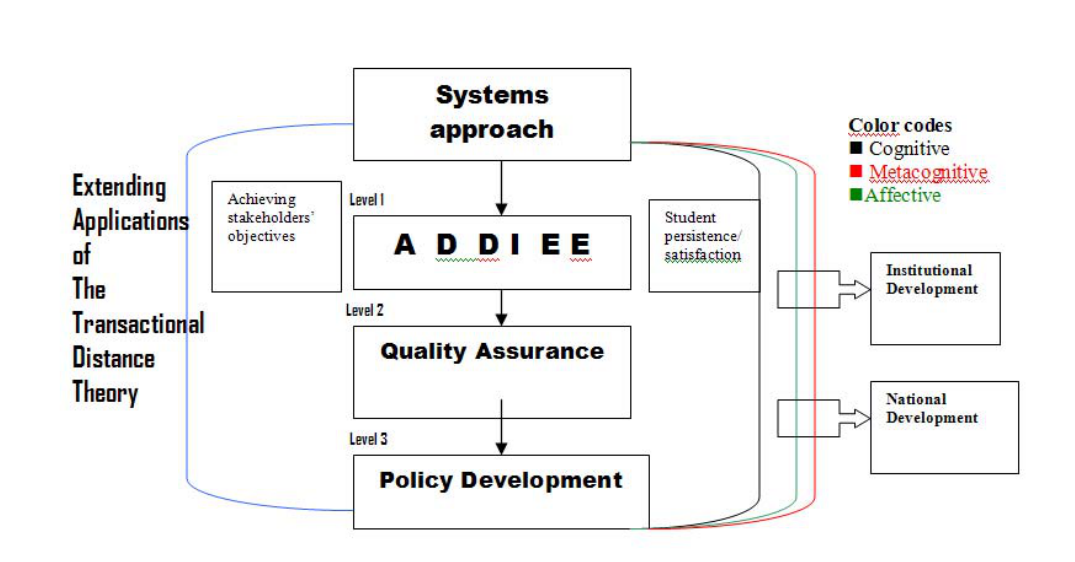
Figure 4. Proposed Model for Extending the Applications of Transactional Distance